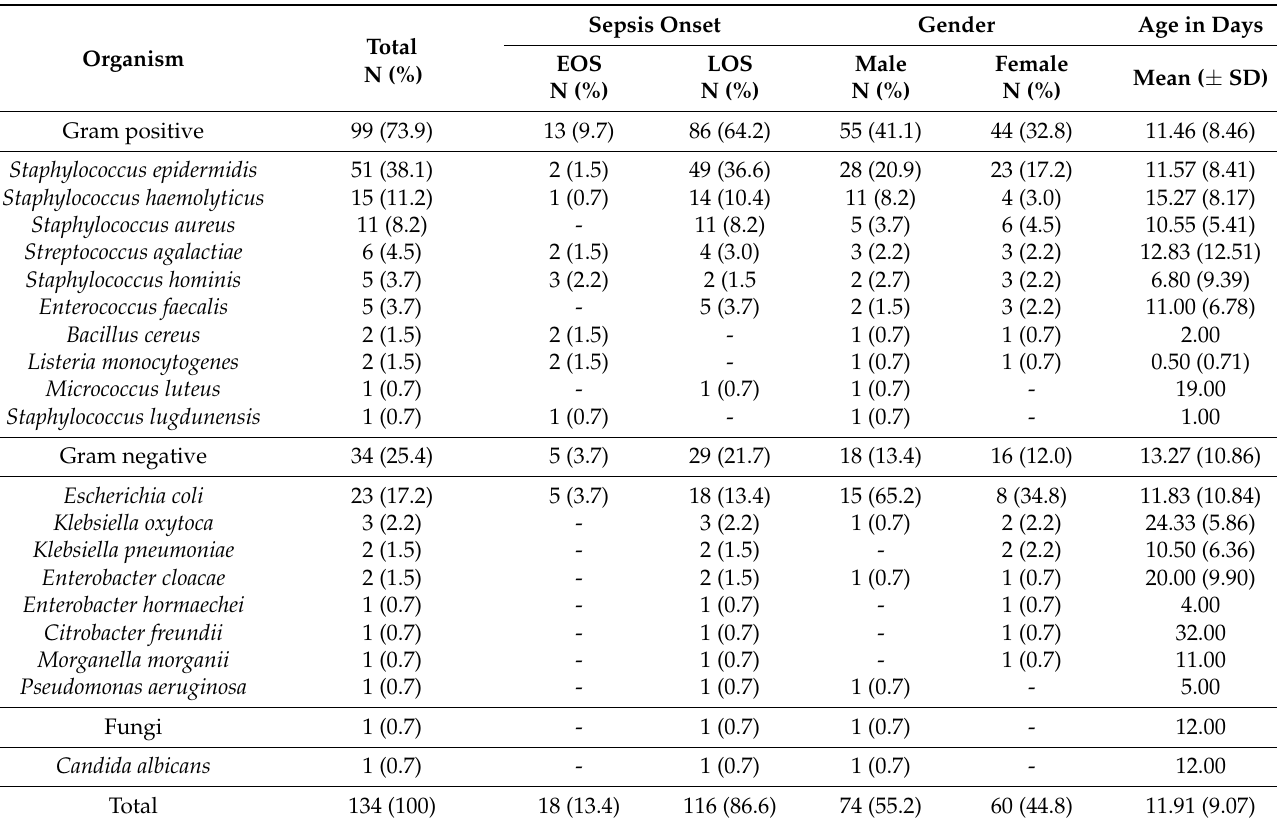
Table 1. Frequency of organisms isolated from neonatal sepsis patients according to sepsis onset, gender, and age of the